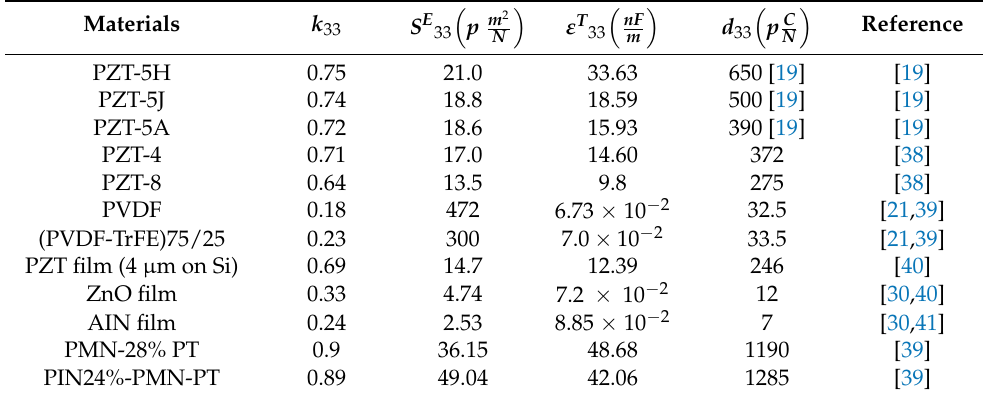
Table 2. Potential piezoelectric materials and their properties selected for the analysis.